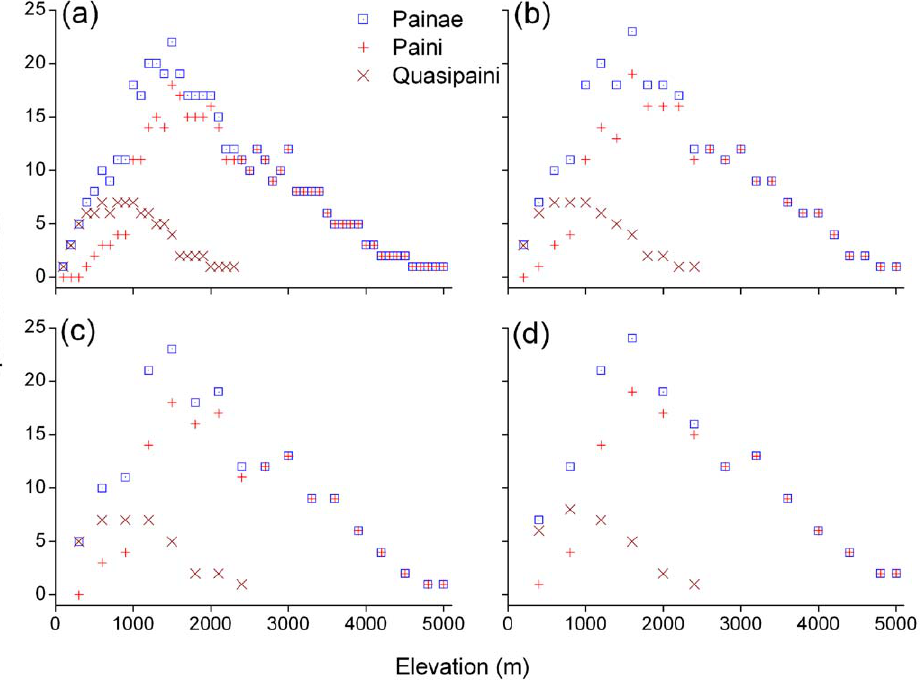
Figure 2. Elevational patterns of species richness of spiny frogs. Patterns are shown for the subfamily Painae ( n =41) and the tribes Paini ( n =33) and Quasipaini ( n =8) along the four altitudinal gradients: (a) 100 m interval, (b) 200 m interval, (c) 300 m interval and (d) 400 m interval.